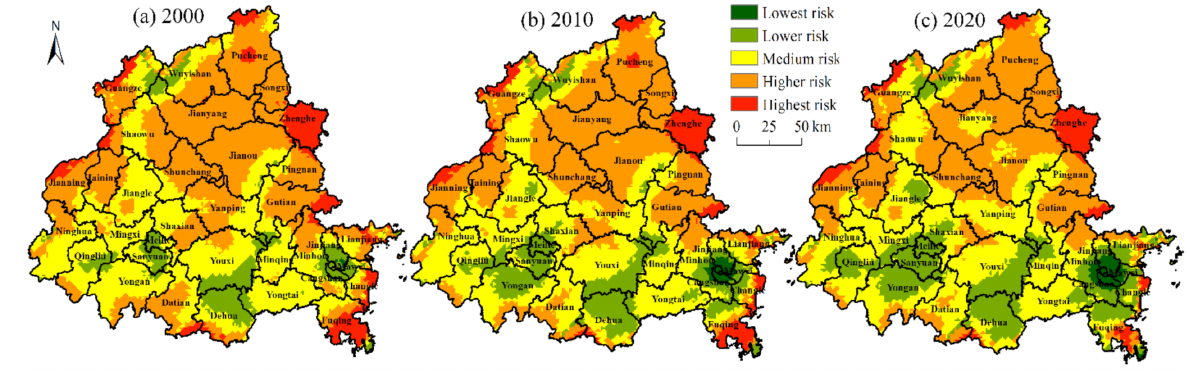
Figure 2. ( a – c ) Spatial distribution map of landscape ecological risk from 2000 to